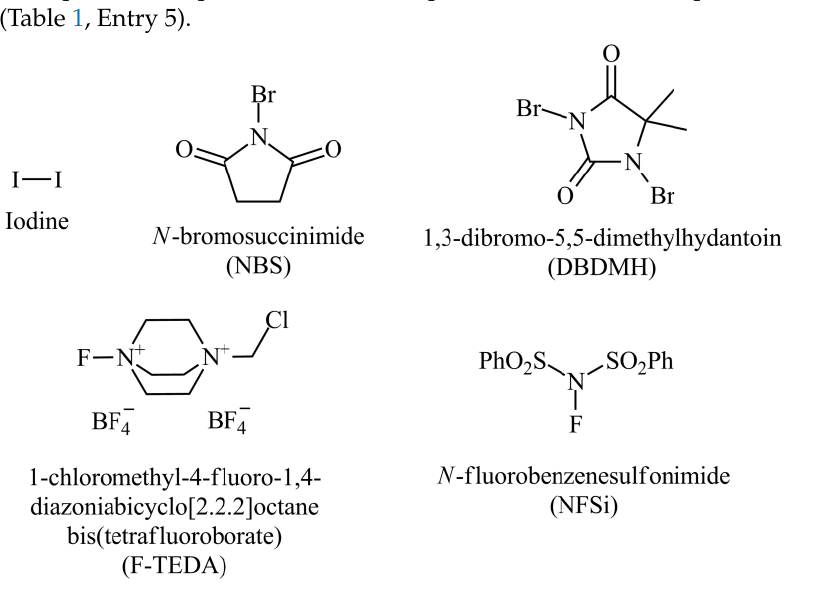
Figure 1. Structures of utilized molecules as putative catalysts for direct esterification under MW irradiation: molecular iodine — I 2 ; N -bromosuccinimide — NBS; 1,3-dibromo-5,5-dimethylhydan- toin — DBDMH; N -Fluorobenzenesulfonimide — NFSi;